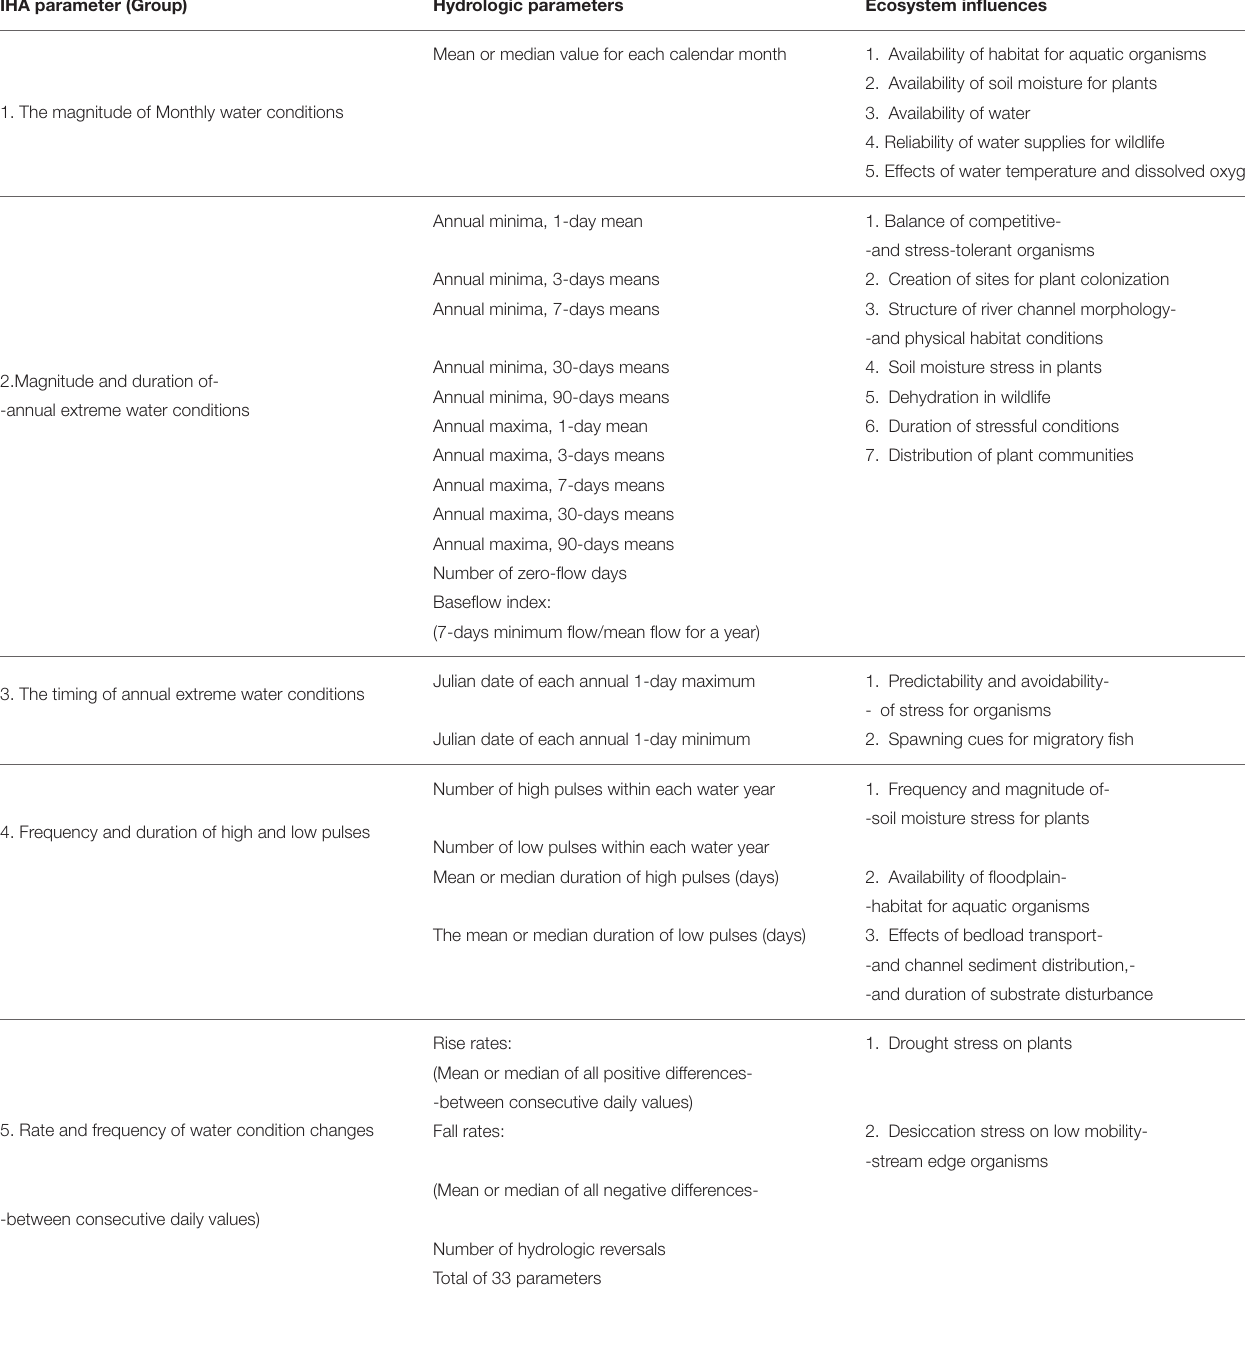
TABLE 1 | Summary of IHA parameters (Swanson,